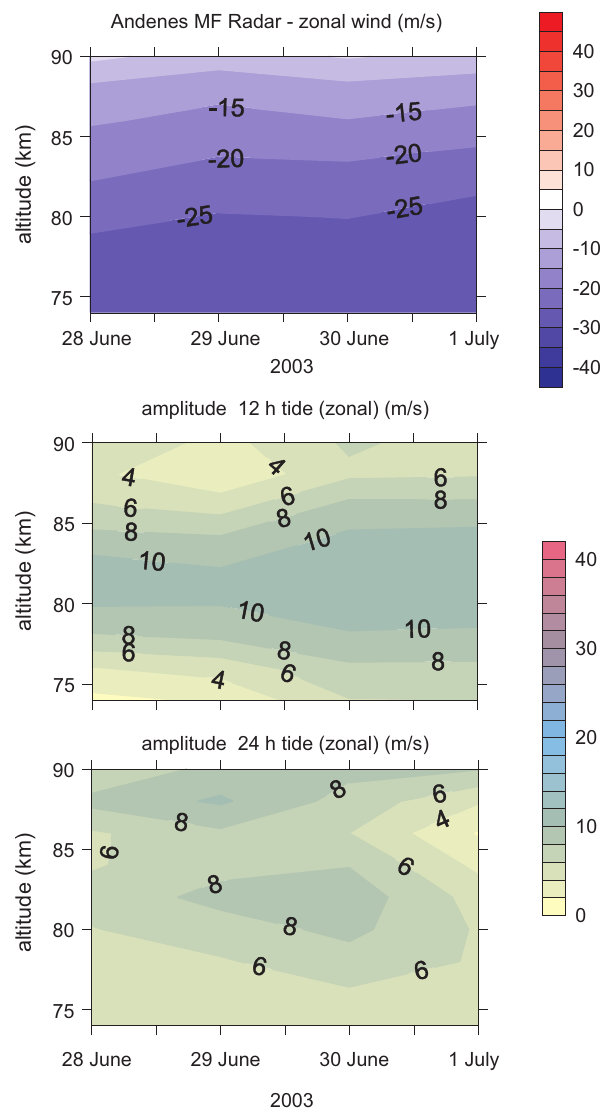
Fig. 13. Mean zonal wind and amplitudes of their semidiurnal and diurnal variation derived from Andenes MF radar observations from 28 June–1 July